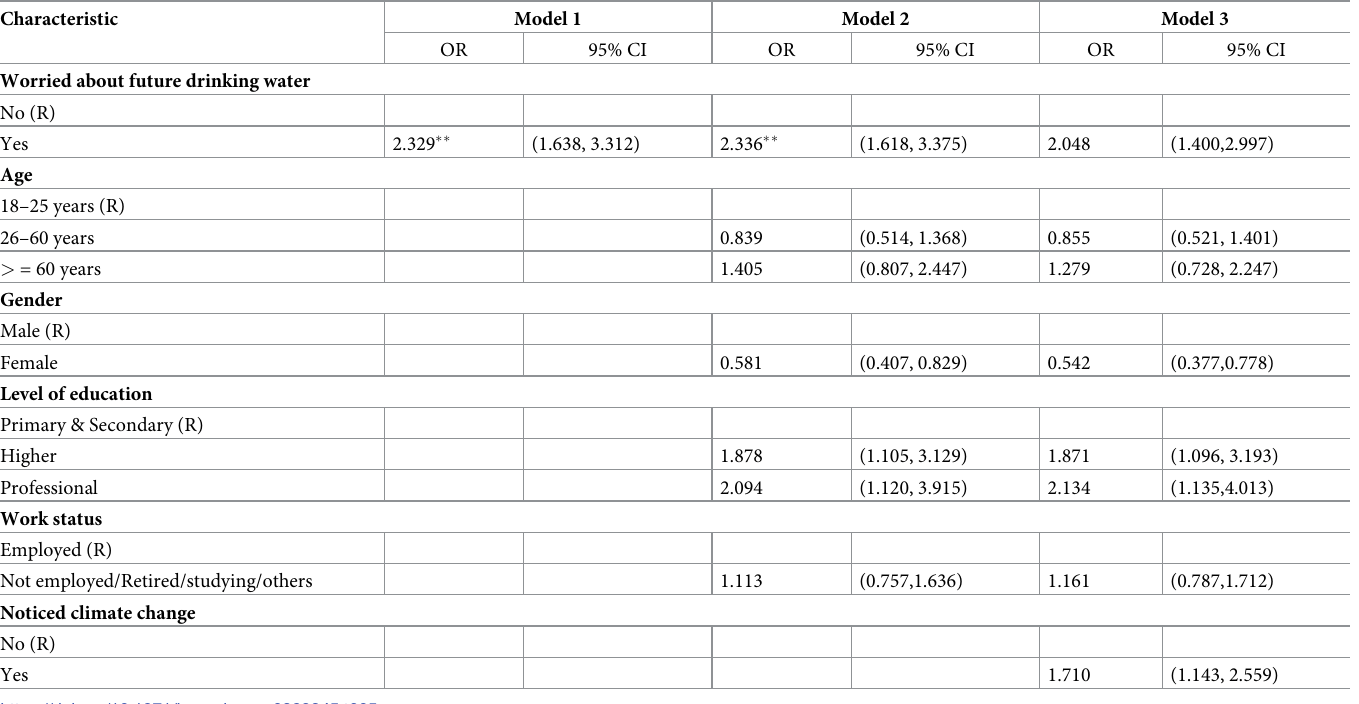
Table 5. Logistic regression results showing odds ratios (OR) and their 95% confidence intervals (CI) predicting support to recycled